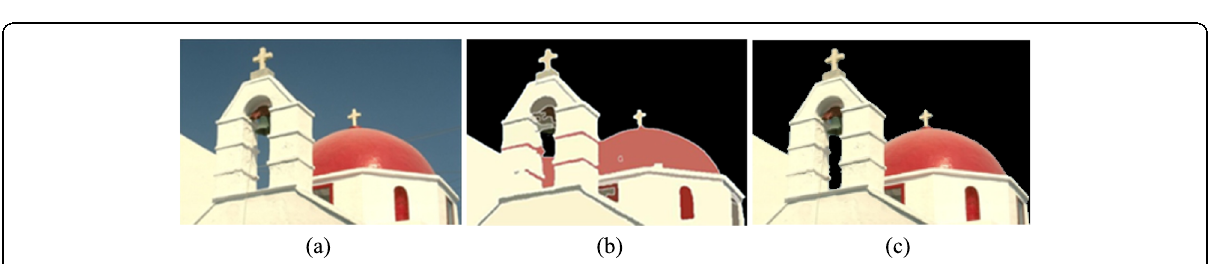
Fig. 10 Comparison. a Original figure. b Result of Watershed algorithm. c Result of this